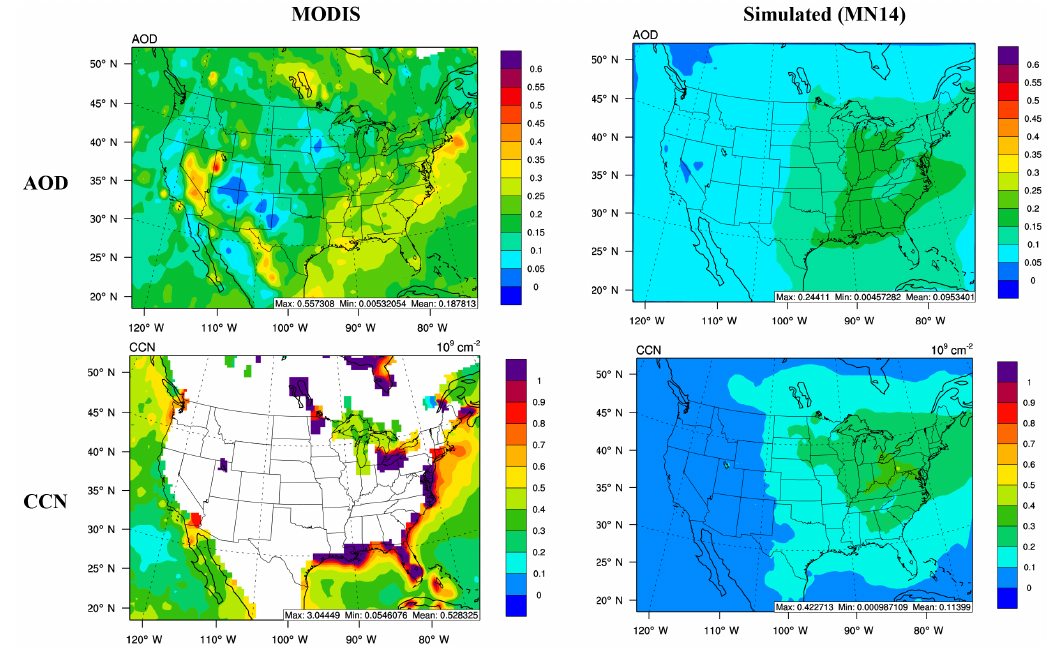
Figure 12. Spatial plots of MODIS CCN and AOD against simulated CCN and AOD from MN14 with